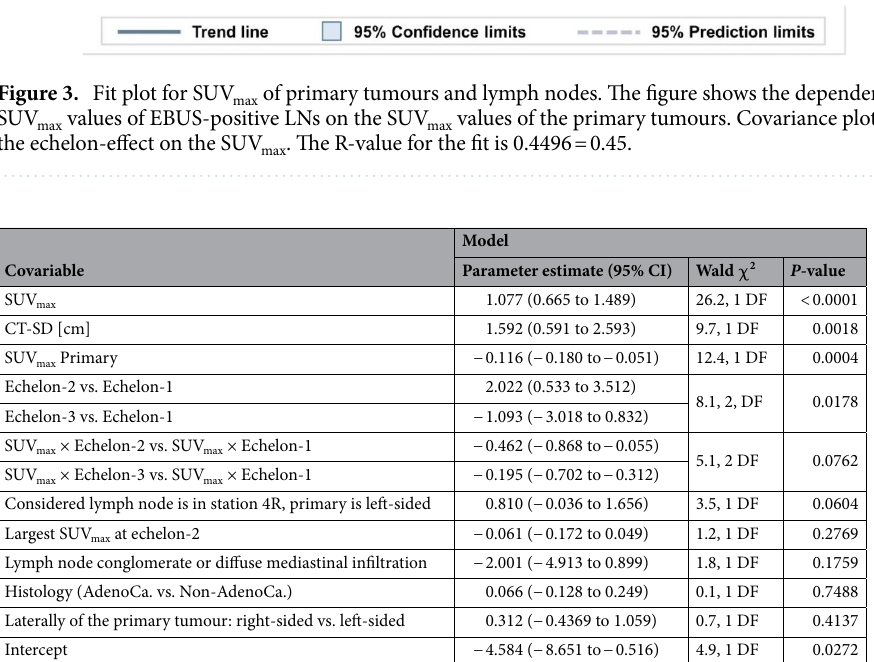
Table 2. Logistic model for prediction of EBUS-positivity of the respective lymph node using PET and CT information about the lymph node as well as parameters about the primary tumours and the mediastinal lymph node spread. Model was fitted to the entire dataset. Parameter estimates are given with 95%-confidence intervals, χ 2 - and P -values and degrees of freedom (DF) are presented for each parameter. The weighting factor for EBUS-positive nodes was set ninefold higher than for EBUS-negative nodes. CT-SD CT short-axis diameter of the lymph node.